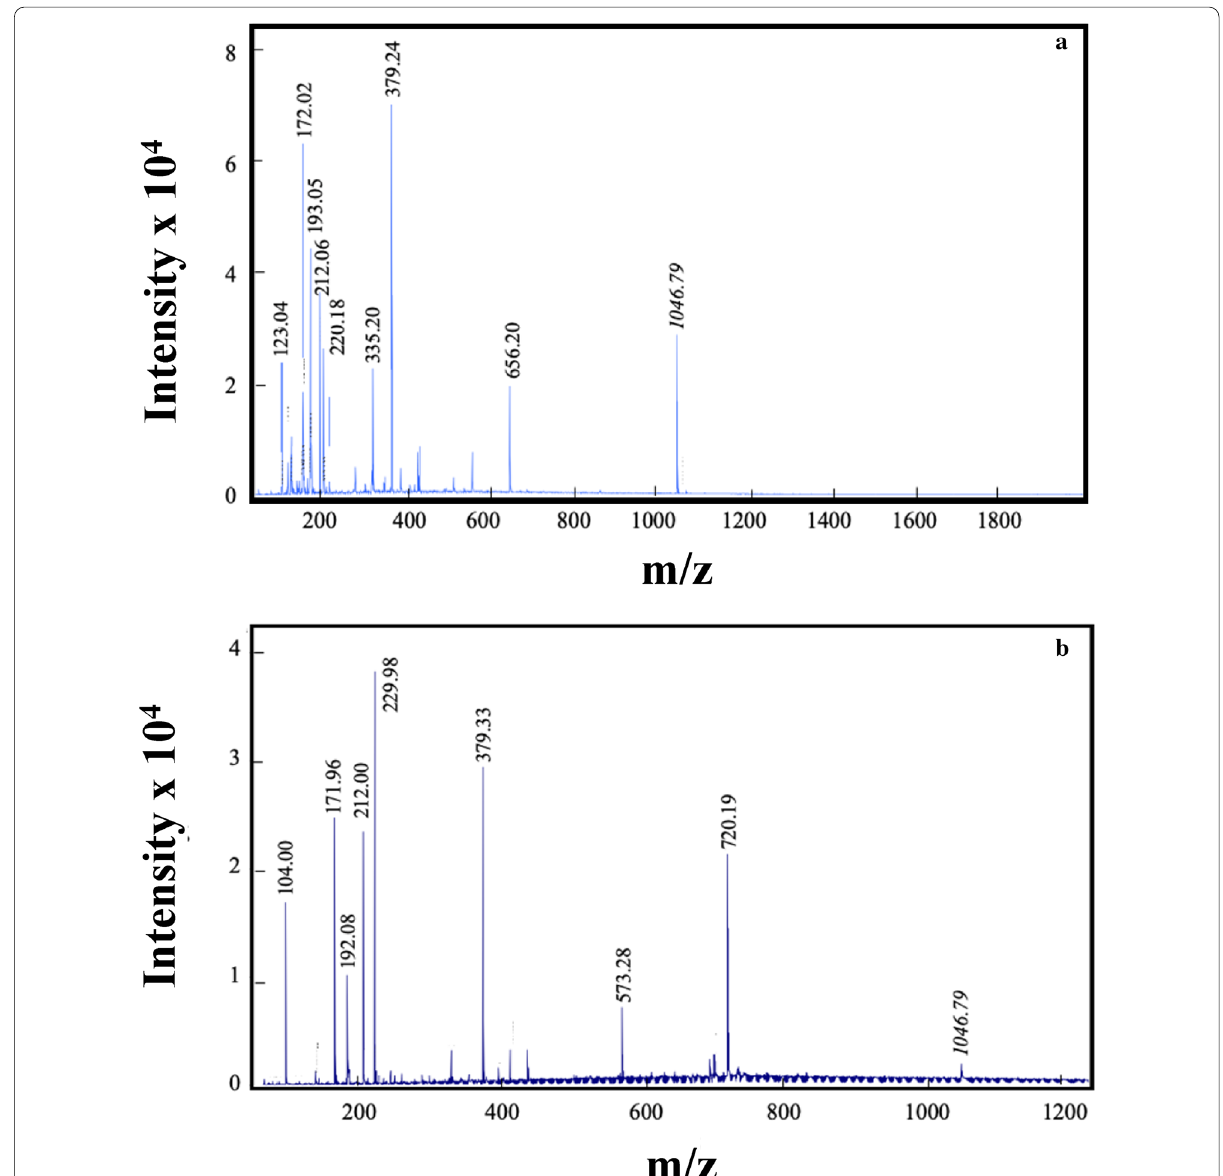
Fig. 2 MALDI-TOF-mass spectra of a CPH I and b CPH II. A signal for a peptide with a known MW is included as a reference at 1046.79